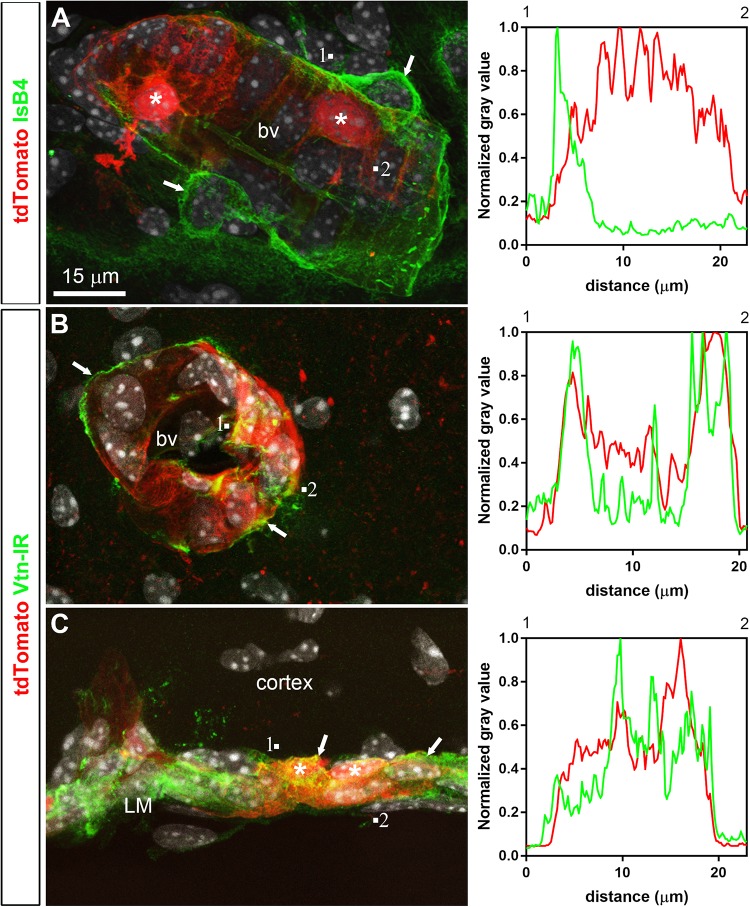
Distribution of perivascular markers relative to tdTomato-labeled cells. (A) Isolectin B4 binding occurred at the surface of endothelial cells, around perivascular macrophages (arrows) and perivascular tdTomato cells (asterisks). (B,C) Vitronectin immunoreactivity was observed decorating the abluminal surface of blood vessels in the parenchyma and leptomeninges (arrows). Intensity plot profiles (between 1 and 2) demonstrated that the surface of most perivascular tdTomato-labeled cells (asterisks) was immunoreactive for vitronectin. DAPI was converted to gray. Scale bar in (A) applies through (C).